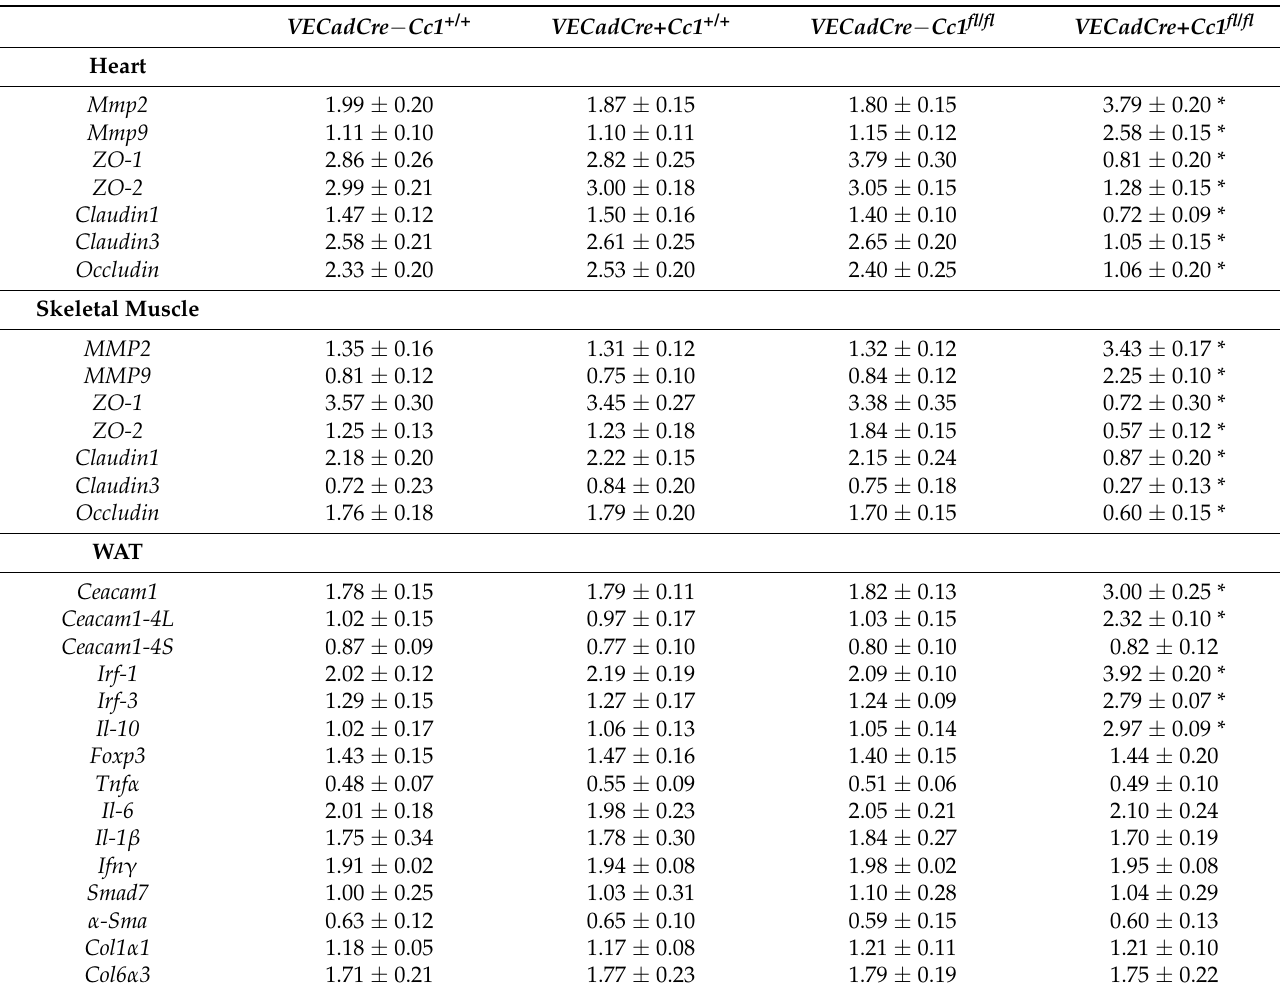
Table 2. qRT-PCR analysis of genes in tissues from 8-month-old